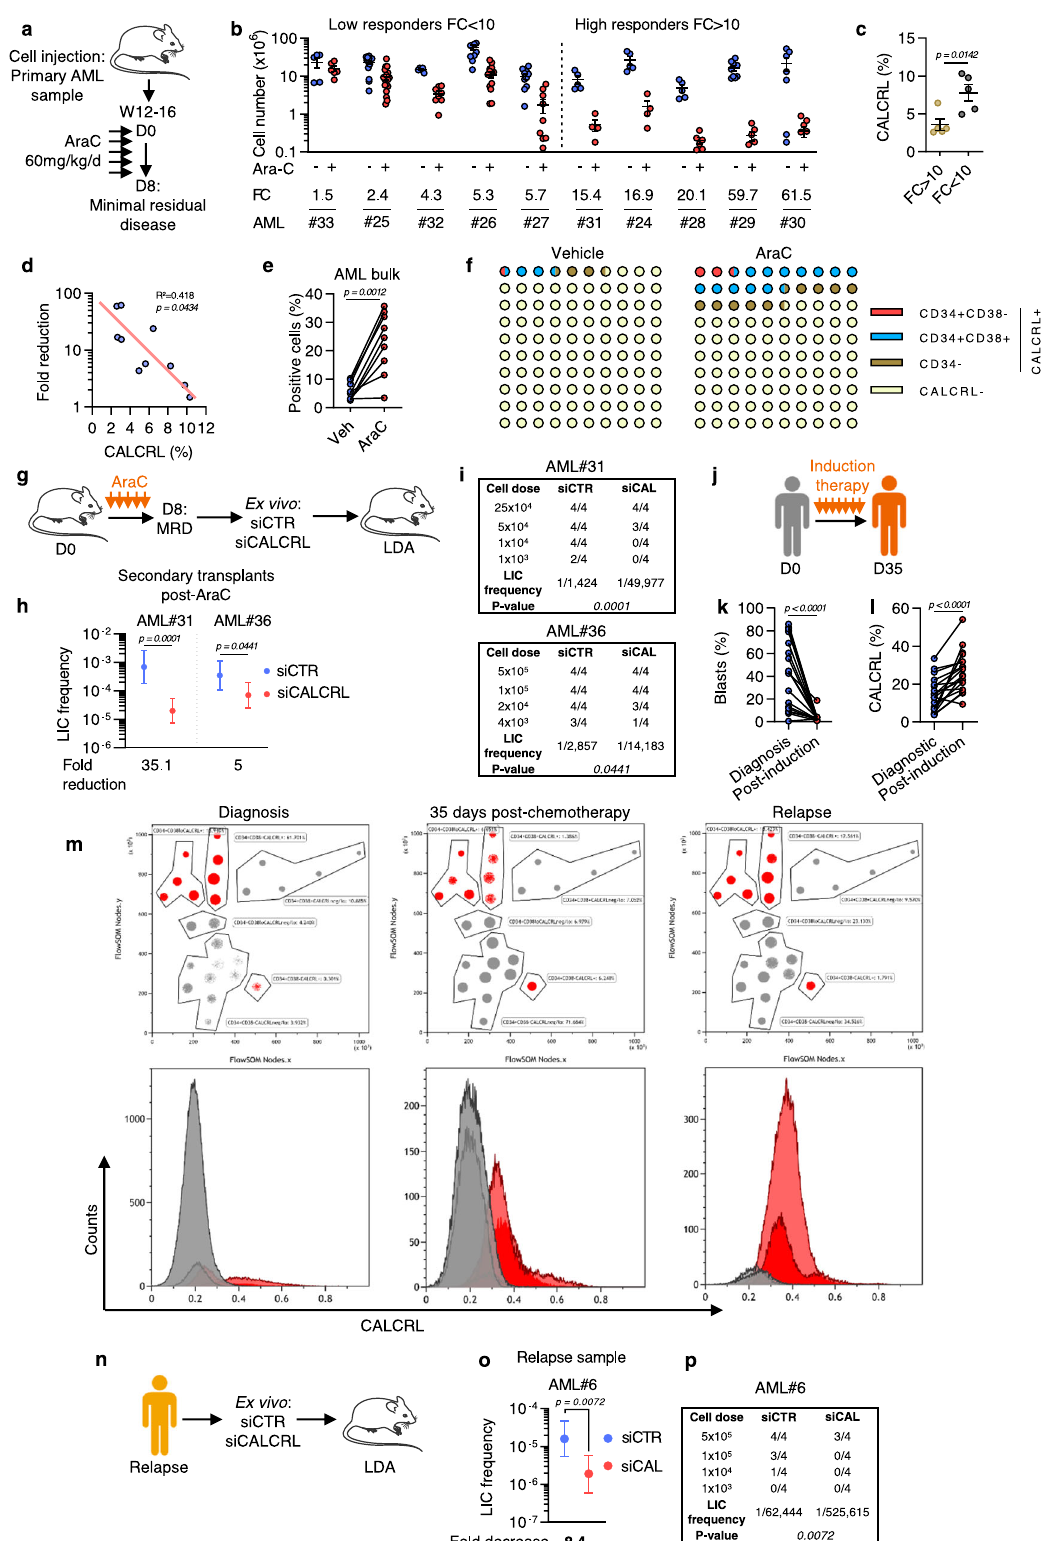
Interestingly, CALCRL was strongly increased at relapse in ROp patients, which correlated with the emergence of a clone with stem cell properties at this stage of the disease (Fig. S9d). These observations supported the hypothesis of the preexistence of a relapse-relevant LSC population, rare (ROp) or abundant (ROc), expressing high levels of CALCRL